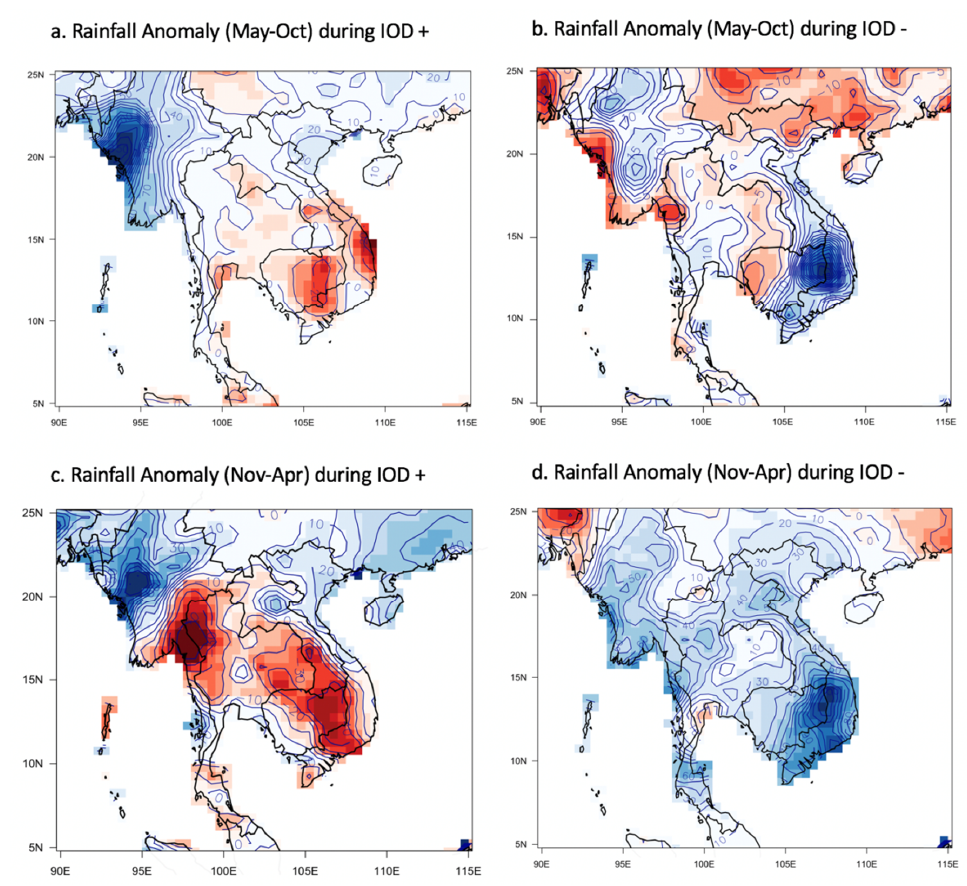
Figure 7. Composite of seasonal rainfall anomaly (%) during positive and negative IOD years: ( a ) rainfall anomaly in wet season during positive IOD years, ( b ) rainfall anomaly in wet season during negative IOD years, ( c ) rainfall anomaly in dry season during positive IOD years, and ( d ) rainfall anomaly in dry season during negative IOD years. Positive (negative) values show increasing (decreasing) rainfall departure from the long-term average (1981–2010).